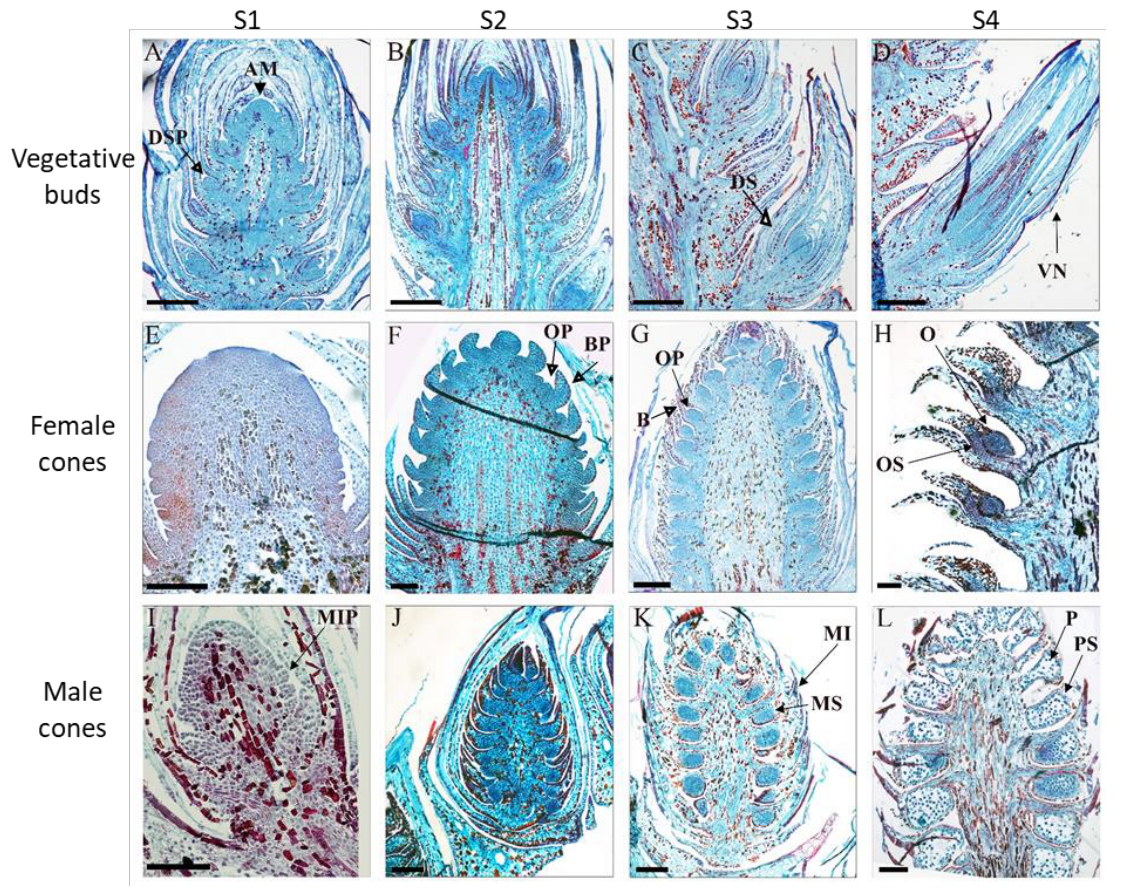
Figure 2. Longitudinal sections of vegetative, female and male P. halepensis buds at different devel- opmental stages. ( A – D ) Vegetative buds developmental stages. ( A ) S1, Dwarf shoot (Brachyblasts) primordia (DSP) with apical meristem (AM). ( B ) (S2) and ( C ) (S3), Dwarf shoots (DS) emerge through the scales. ( D ) S4, Visible needles (VN). ( E – H ) Female cones developmental stages. ( E ) S1, Bulge-like structure enclosed within the scales with few lateral bract anlagen. ( F ) S2, bract primordia (BP) and ovuliferous primordia (OP). ( G ) S3, Bracts (B) are fully developed covering the developing ovuliferous scales. ( H ) S4, bract and ovuliferous scale (OS) complex with developing ovule (O). ( I – L ) Male cones developmental stages. ( I ) S1, Lateral microsporophyll primordia (MIP). ( J ) S2, Young cones hidden within the scales, contains developing microsporophyll. ( K ) S3, Cone emergence from bud scales and the microsporophyll (MI) contains microsporangium (MS). ( L ) S4, fully developed cones with pollen sacs (PS) and pollen mother cells (P). Scale Bar, ( A – E , I ) 500 µ M, ( F – H , J – L ) 250 µ